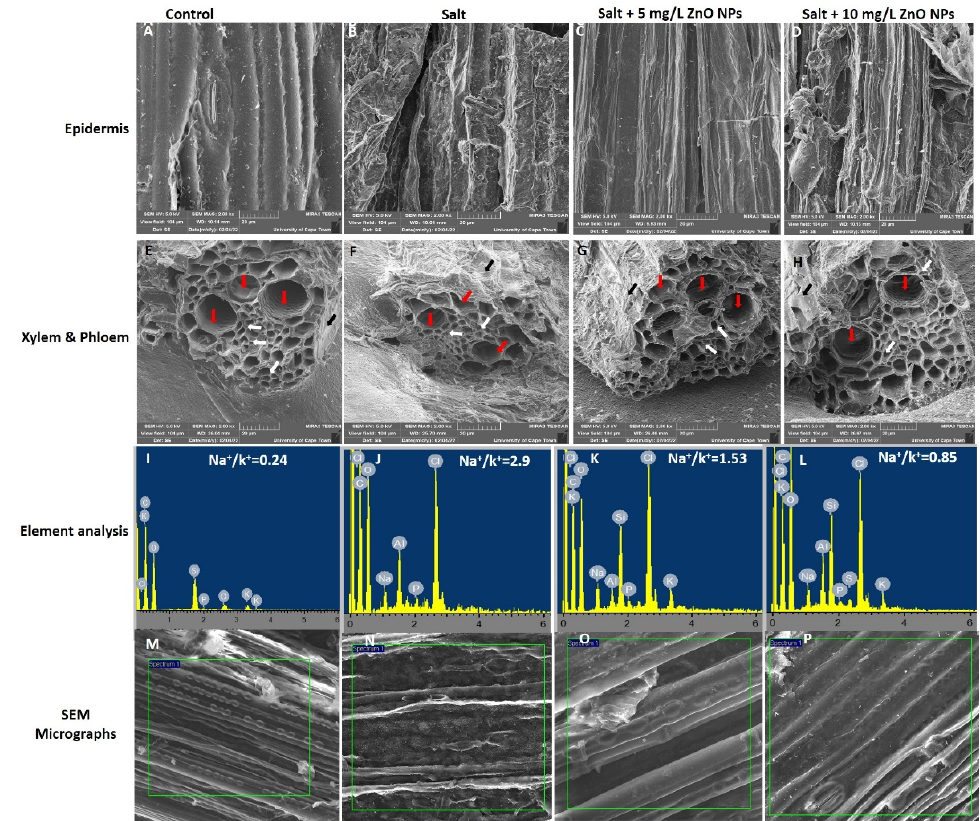
Figure 3. Effect of salt and the priming of the ZnO NPs on the anatomy and element distribution in sorghum plants. ( a – d ) Epidermis layers, ( e – h ) Xylem and phloem, ( i – l ) element content, ( m – p ) SEM micrographs for the EDX-investigated area.